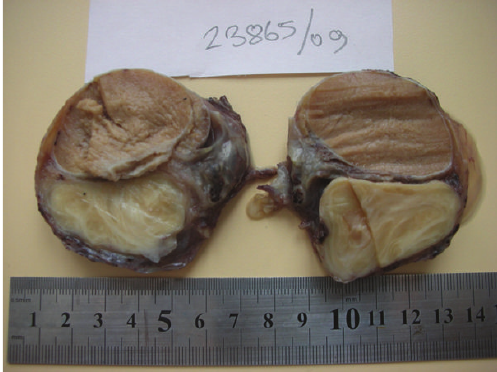
Figure 1: Gross pathological view of the testis and epididymal tumor.